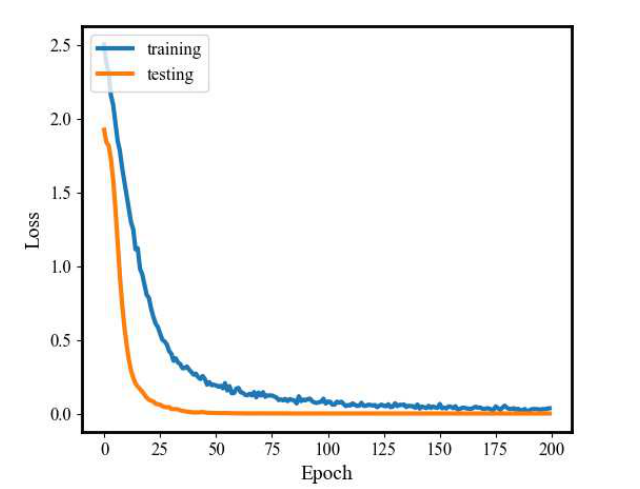
Figure 8. 1D-SCNN model